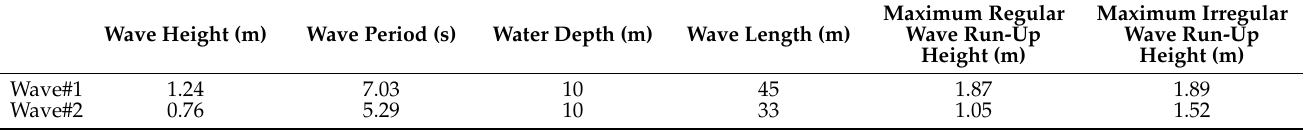
Table 1. Typical wave conditions and maximum wave run-up heights.